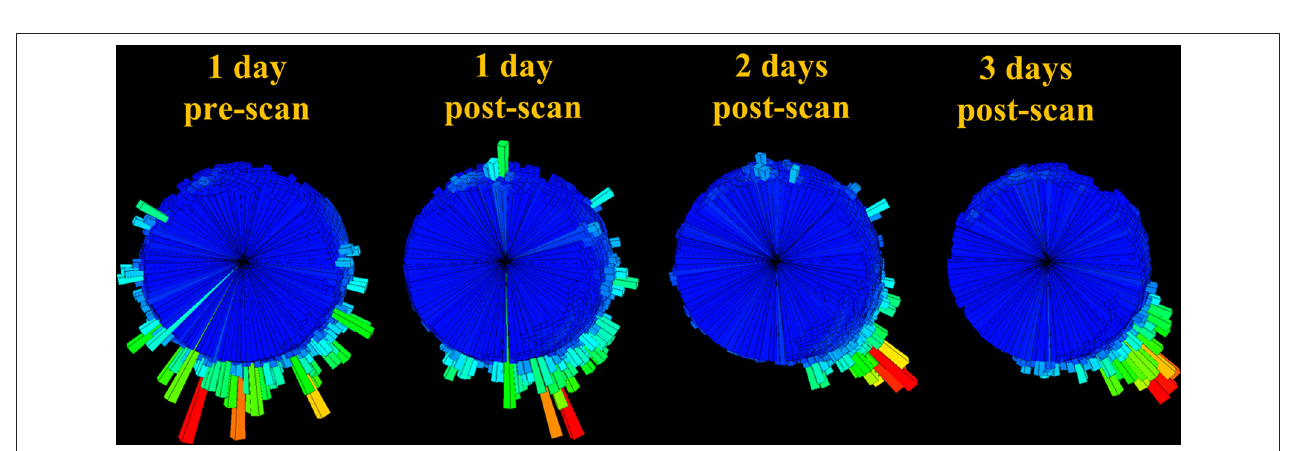
FIGURE 8 | Body orientation histogram (rose plot) over 24h time-periods for T383 prior to undergoing an MRI scan and for the 3 days following this. Bar length denotes length of time allocated to each direction (the mode is shown in red). Note how the appreciable variability pre-MRI scan appears to diminish with time after the